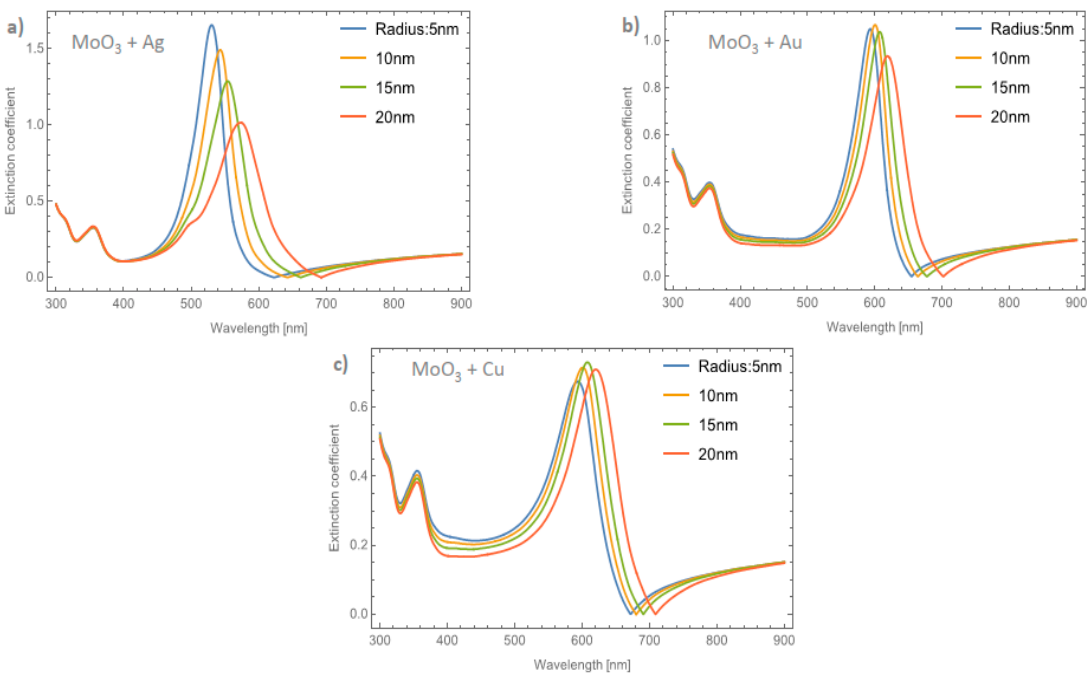
Figure 7. The extinction coefficient of the MoO 3 thin film doped with ( a ) Ag-NPs, ( b ) Au-NPs, and ( c ) Cu-NPs for a volume filling fraction of 5%. In all spectra, the thickness was fixed to a value of 120 nm, and different NPs radii are labeled.